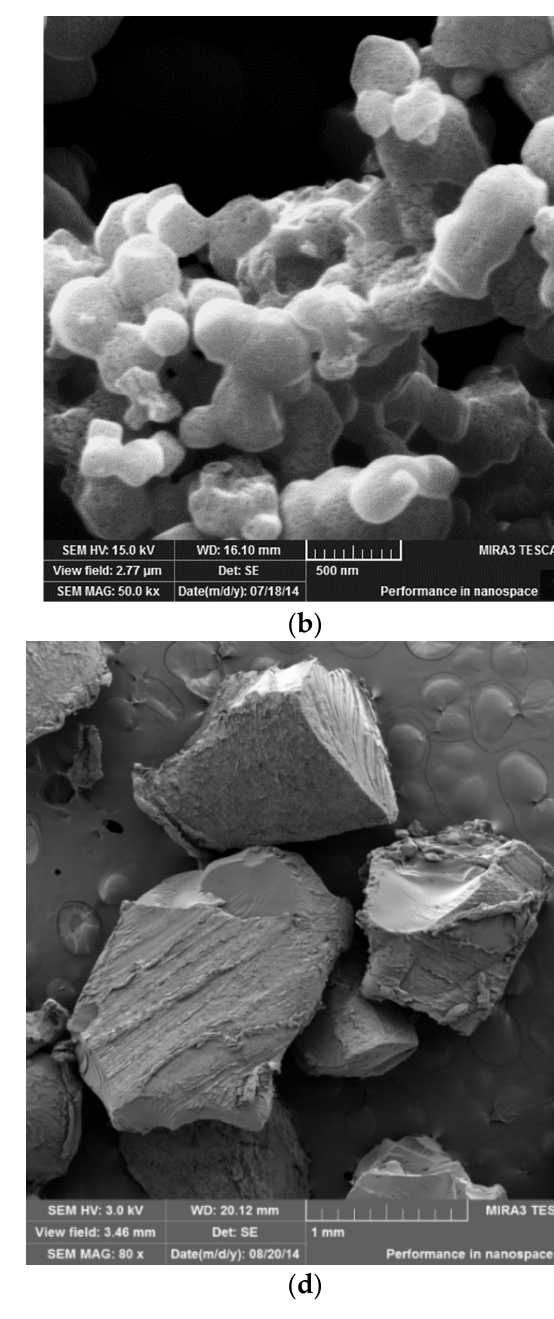
Figure 3. SEM–FEG images of as–received AgNO 3 ( a ); Ag 2 O resulting from the oxidation of AgNO 3 ( b ); (Ag) resulting from the reduction Ag 2 O ( c ); as–received PVA ( d ).